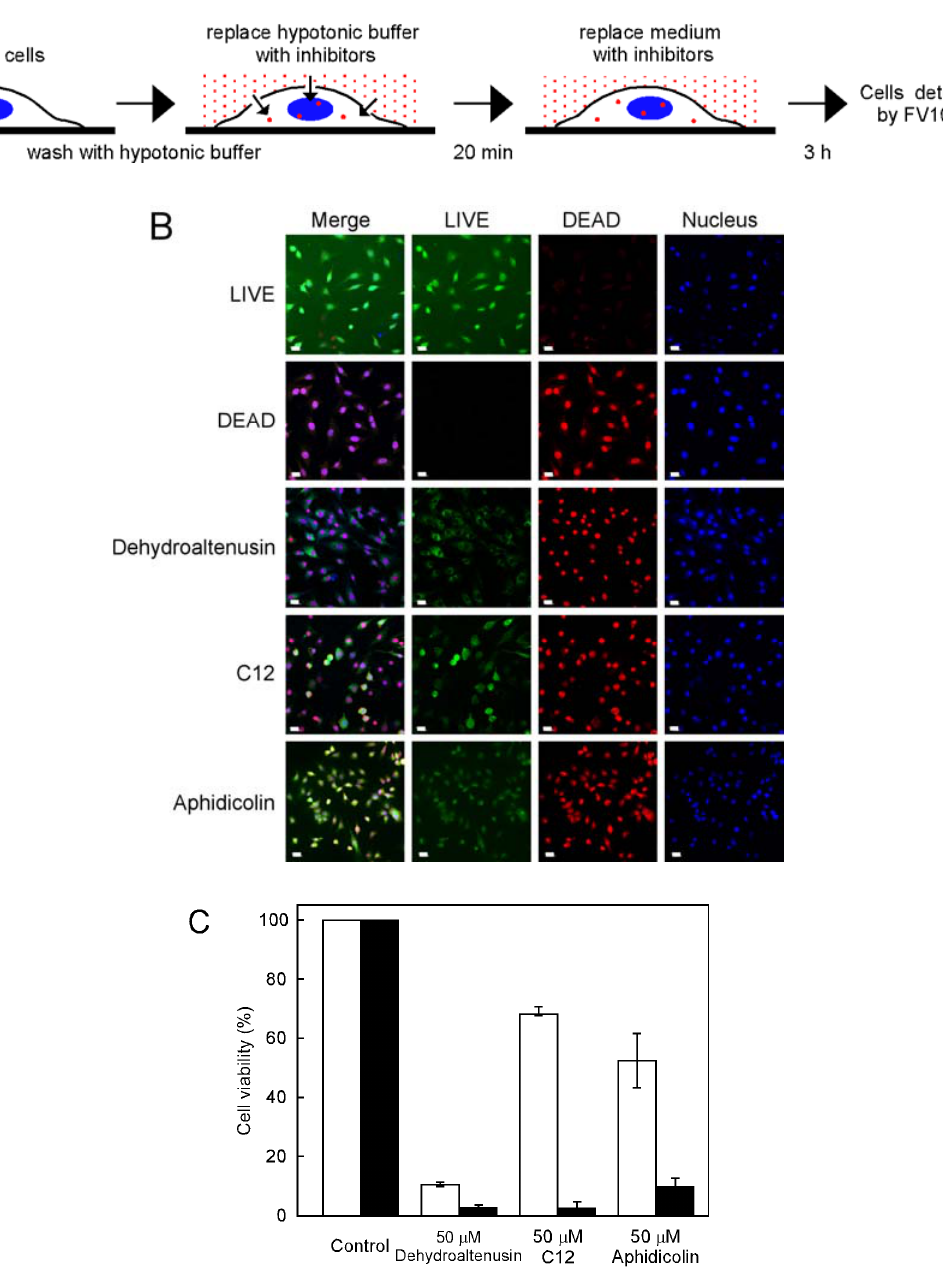
Figure 4. Inhibitors were incorporated into cells using a hypotonic shift. (A) Scheme of the procedure for a hypotonic shift. (B) NIH3T3 cells incubated for 20 min in hypotonic buffer without or with 50 μ M dehydroaltenusin, C12 or aphidicolin. The culture medium was then replaced with medium including 50 μ M dehydroaltenusin, C12 or aphidicolin for 3 h. Cells were detected using a LIVE/DEAD ® Viability/Cytotoxicity Kit. Red and green indicate dead and live cells, respectively. Dead cells were treated with 70% methanol for 30 min. (C) Cell viability using a hypotonic shift (closed bar) or not (open bar) is shown. Live and dead cells were individually counted from at least 200 cells (from each condition). Control was taken as 100%. Values are shown as the means ± S.E. for four independent experiments. All bars indicate 20 μ